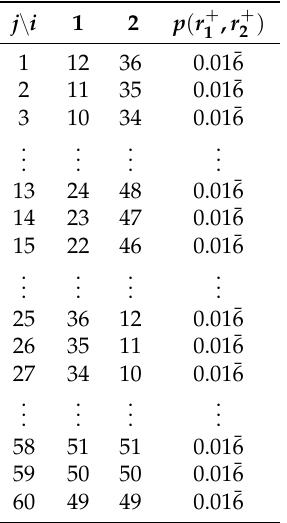
in Example 4. , r ` r ` 2 q 1 p